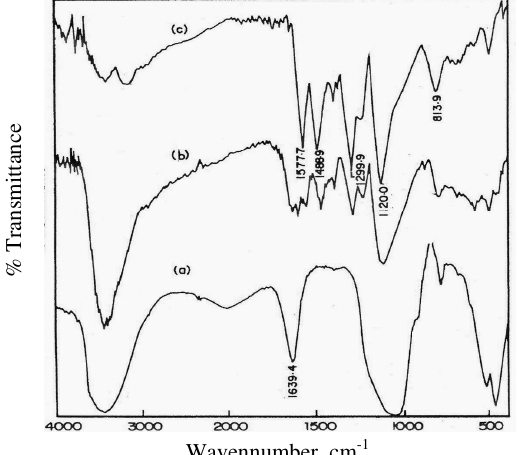
Figure 4. FT-IR spectrum of (a) pristine clay (b) polyaniline clay nanocomposite